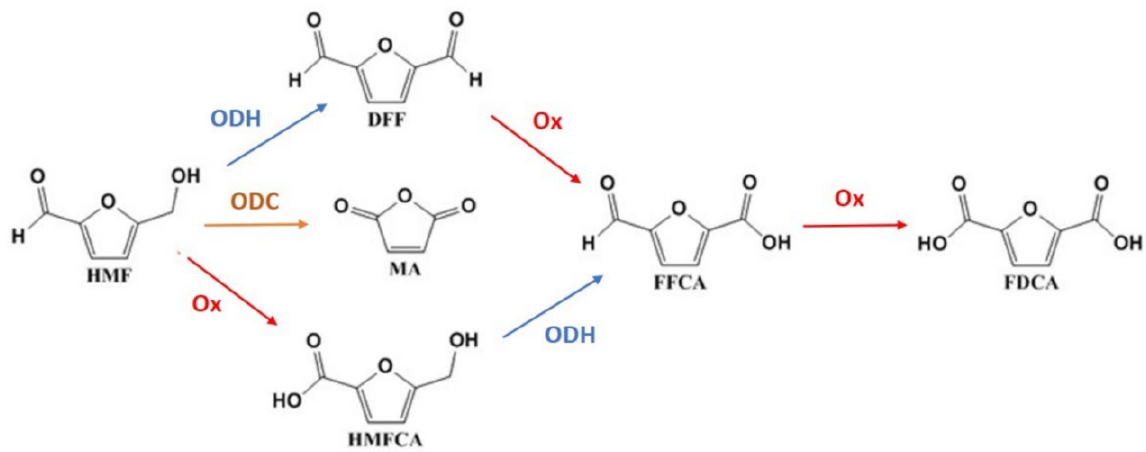
Figure 1. Consecutive-parallel reaction pathways in the oxidation of HMF to FDCA. ODH: oxydehy- drogenation; ODC: oxydecarboxylation; Ox: aldehyde